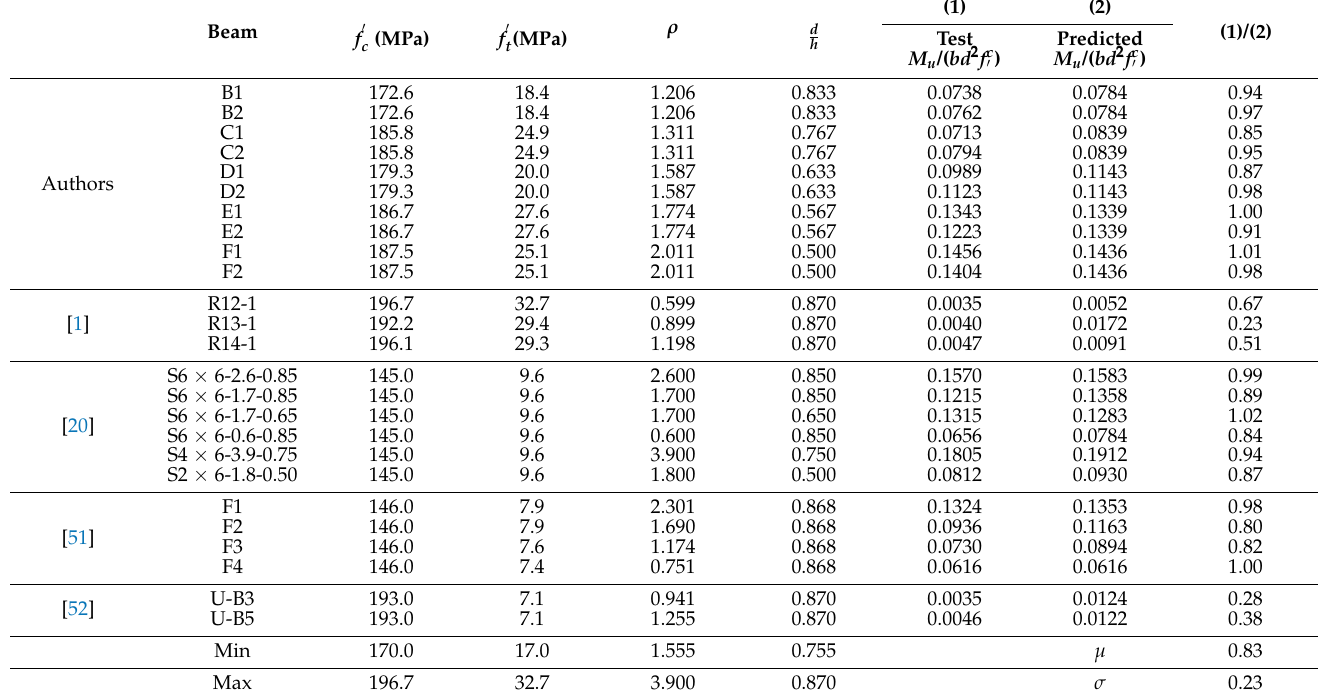
Table 10. Normalized ultimate-moment-model